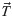
Example of the reference and reconstructed traction fields in the region of a single focal adhesion.The white contour marks the border of the FA as defined in the in-silico model. The total traction force T→ of the FA is plotted in both cases with a black arrow, whereas the white cross-shaped marker indicates the location with the highest traction stress within the FA.